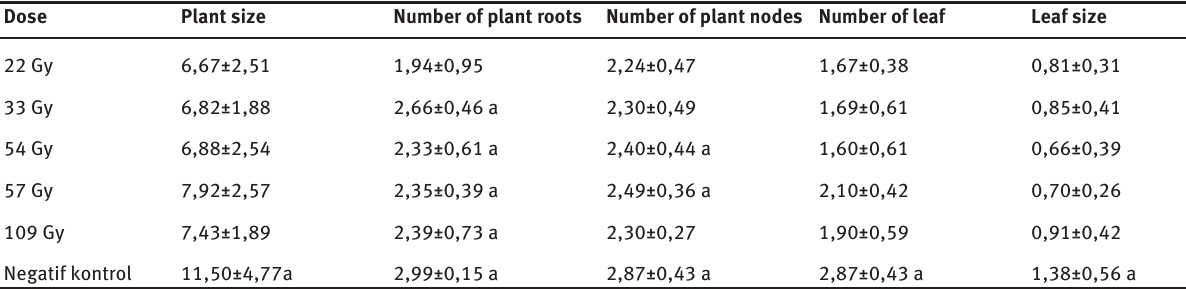
Table 4: Comparision of the plant parameters with the negative control groups. Dose Plant size Number of plant roots Number of plant nodes Number of leaf Leaf